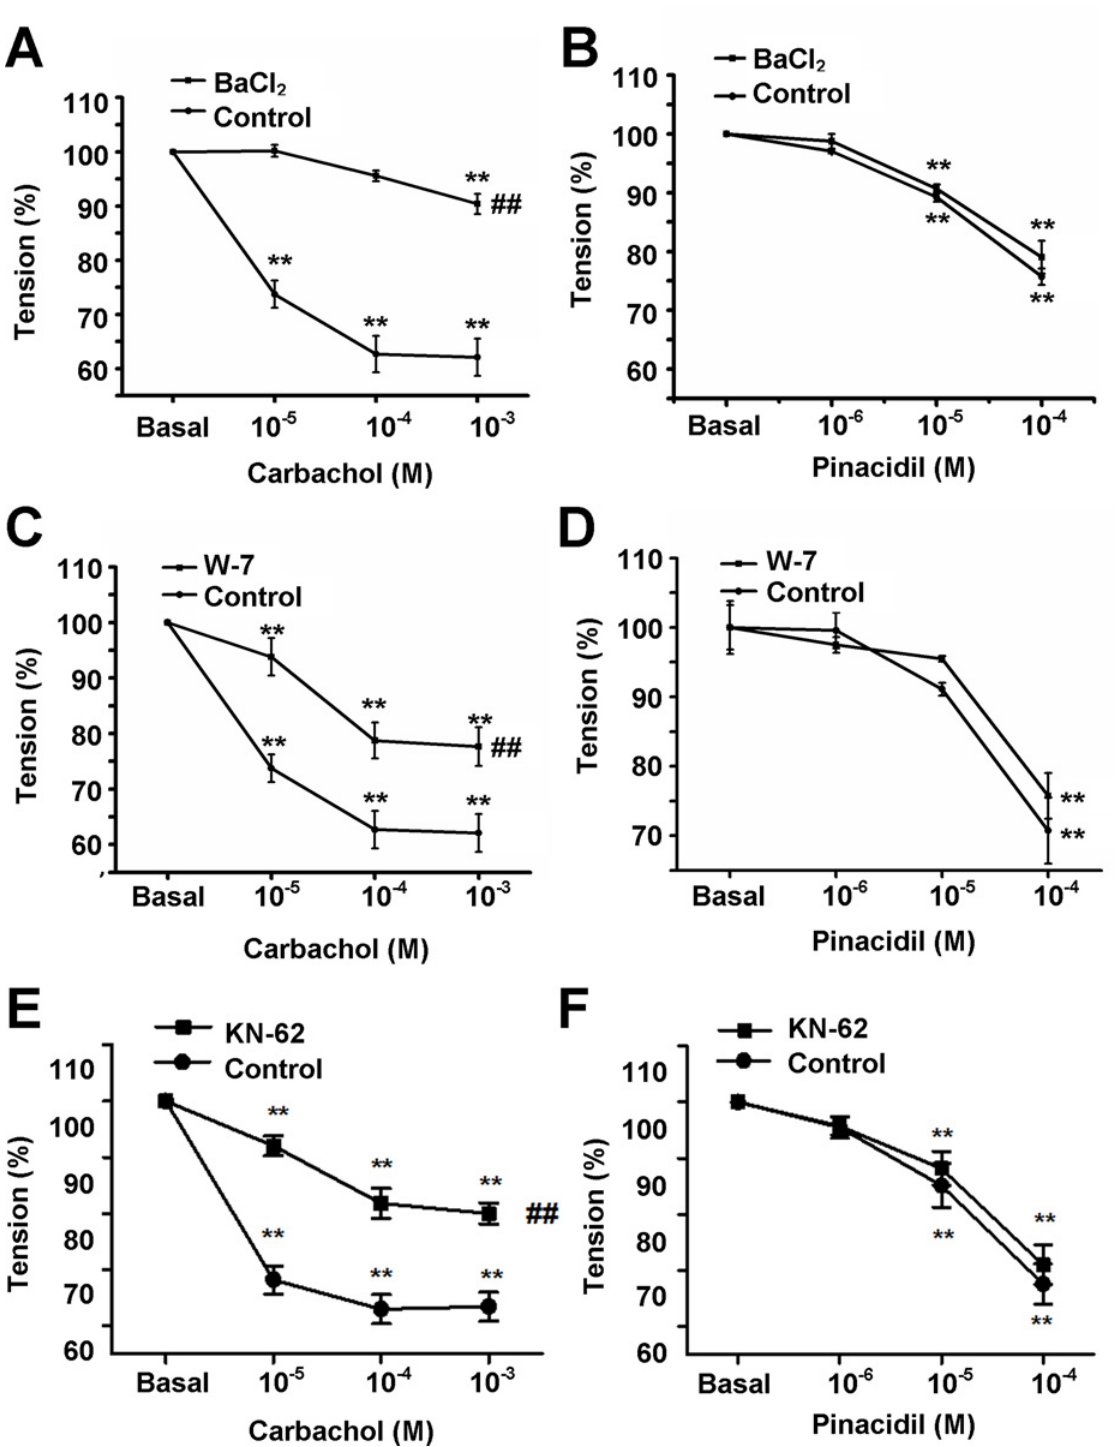
Fig 11. The inhibitive effects of BaCl 2 , W-7 and KN-62on relaxation of PAs. Pretreated the isolated perfused pulmonary artery rings with BaCl 2 (100 μ M) for 20 min (A), W-7 (100 μ M) for 60 min (C) and KN-62 (10 μ M)for 20 min (E), the amplitude of relaxation induced by carbachol (1 μ M) was inhibited significantly (n = 6). When the PA endothelium was removed, the amplitude of relaxation induced by pinacidil was not affected by BaCl 2 (B), W-7 (D) andKN- 62 (F) (n = 6). ** P < 0.01 versus basal value, ## P < 0.01 versus control.